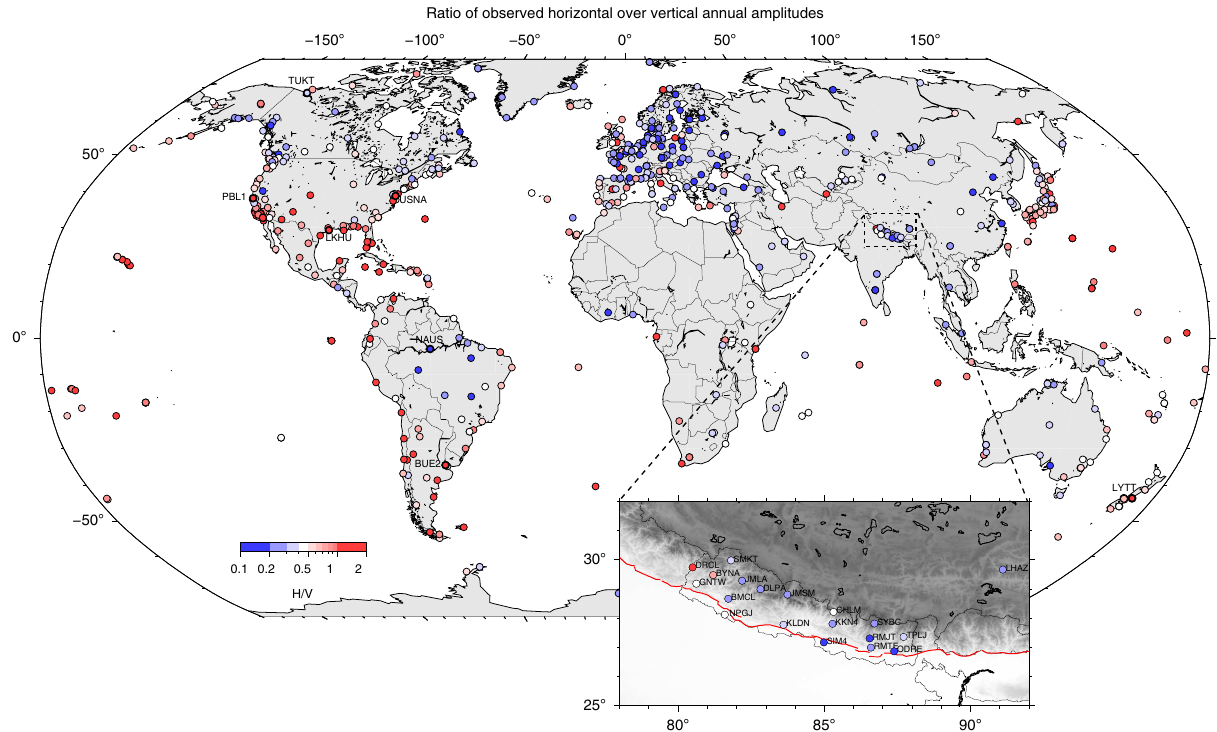
Fig. 1 Observed horizontal over vertical annual amplitudes (H/V) ratio. H/V ratio is shown at a set of 689 globally distributed Global Navigation Satellite Systems (GNSS) stations of the International GNSS Service (IGS) that were a part of the second IGS reprocessing campaign (see Data Availability). Stations for which the North component seasonal signal is shown in Fig. 2c are indicated as bold dots and labelled with their site names. The same ratio is also shown for 18 GNSS stations located in Nepal. Ratios often exceed 0.5 at the global scale, in regions where not tectonic deformation is expected. In Nepal, two stations exhibit higher than 0.5 H/V ratio, in a limited geographic